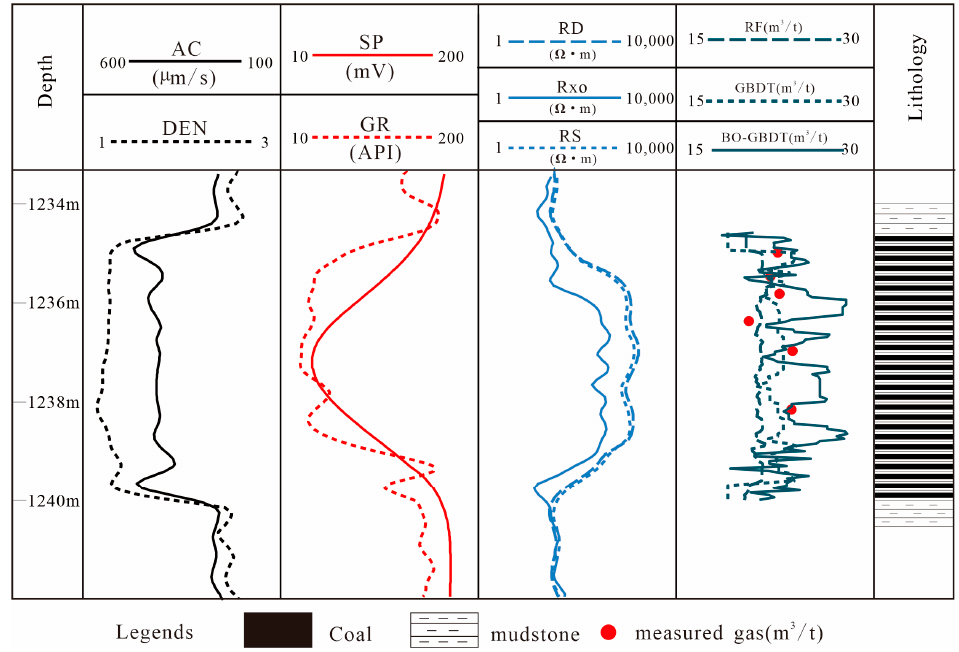
Figure 11. The gas content curve predicted by different models (taking ZS99 well as an example).